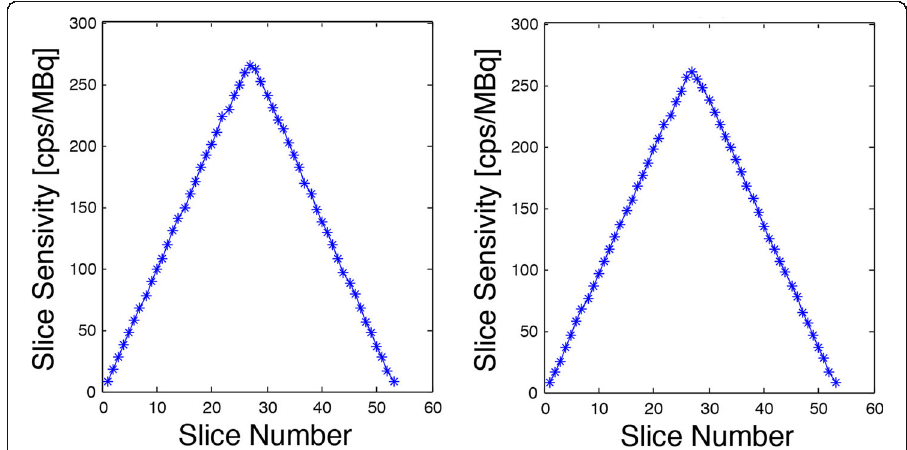
Fig. 1 Slice sensitivity profiles. The left panel shows the profile at the centre of the FOV, the right panel is the profile at a 10-cm radial offset in the Y -direction. As expected, the sensitivity is less than that of a 20-cm